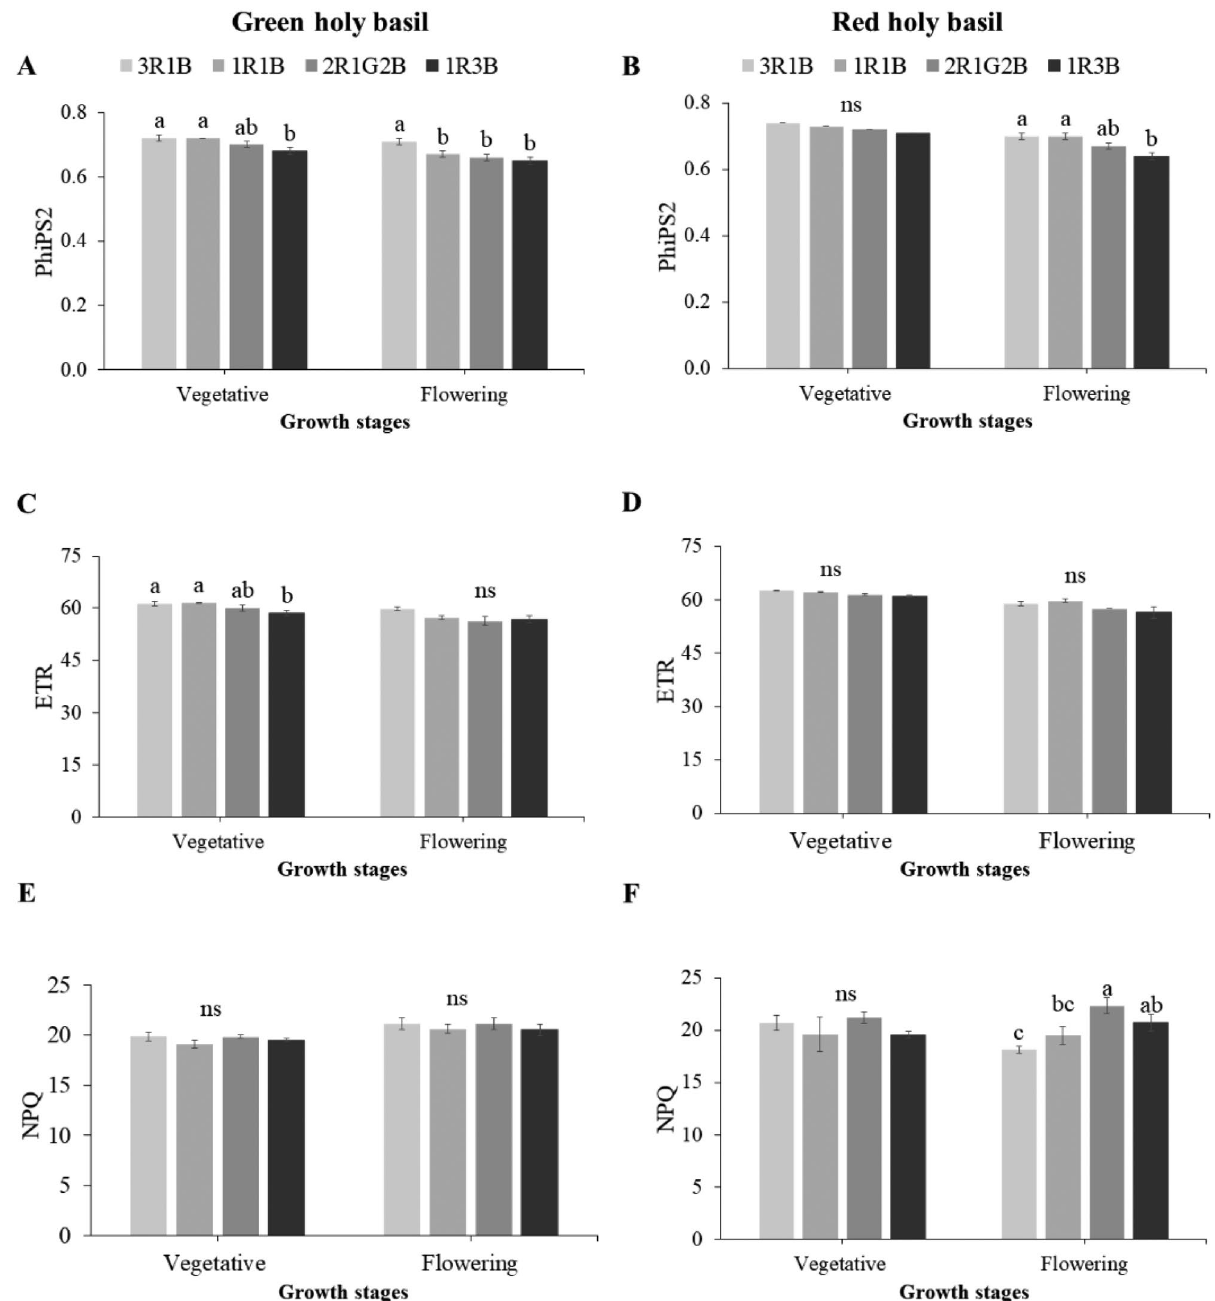
Figure 4. Photosystem II efficiency (PhiPS2, A , B ), electron transport rate (ETR, C , D ), and non-photochemical quenching (NPQ, E , F ) of green and red holy basil at vegetative and flowering stages under four different light treatments (3R:1B, 1R:1B, 2R:1G:2B, and 1R:3B). R, G and B represent the red, green and blue llight spectra, respectively, and number before the letters stand for the ratio of each lighrt spectra. Values are represented as mean ± SE (n = 4). ANOVA was performed followed by mean comparison with DMRT. Lower-case letters above bars indicate significant difference (p < 0.05); “ns” indicates no significant difference. Bars indicate standard